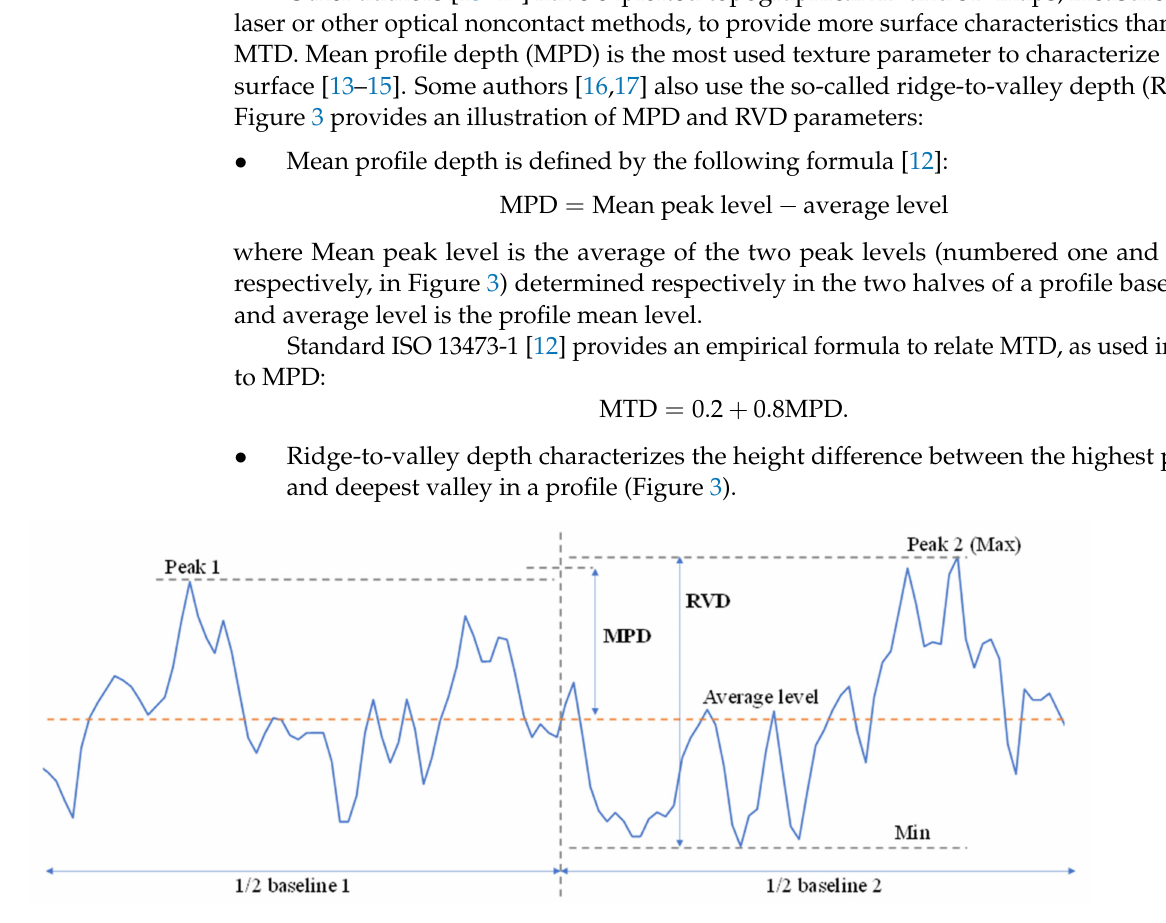
Figure 3. Definition of the mean profile depth (MPD) and the ridge-to-valley depth